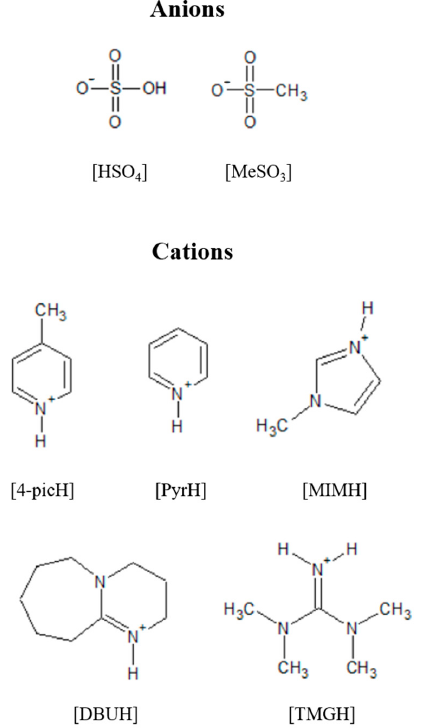
Figure 1. Molecular structures of the studied anions and cations.